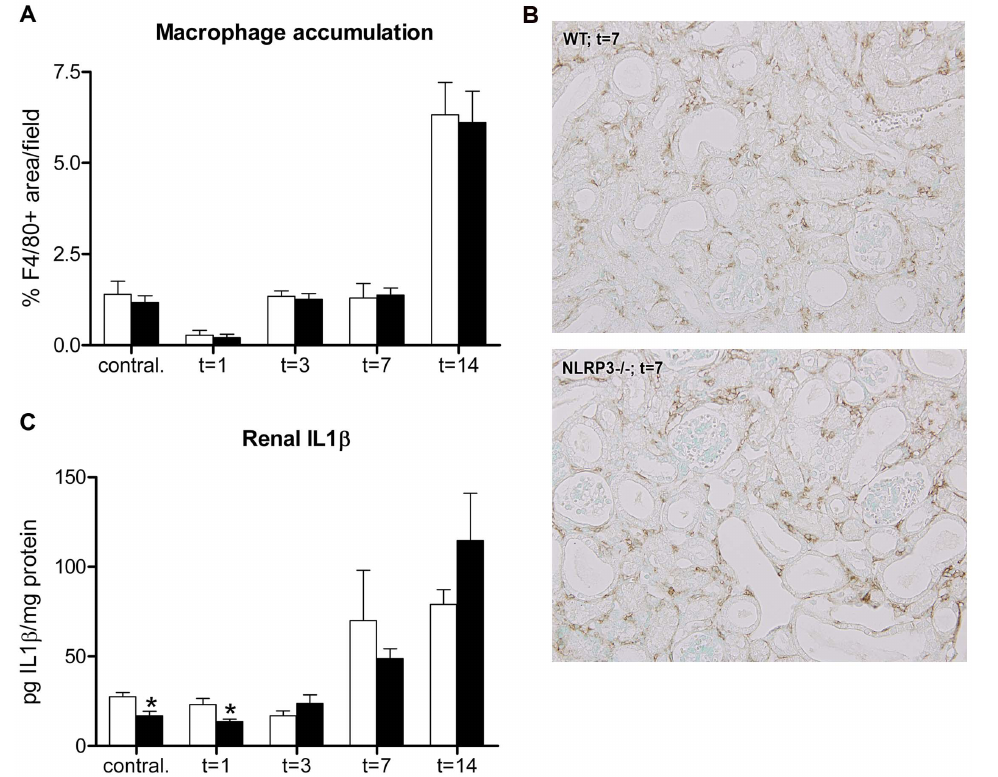
Figure 6. Nlrp3 deficiency reduces early renal IL1- b levels but does not affect macrophage accumulation following UUO. (A) Macrophages progressively accumulated in obstructed kidneys upon UUO and were comparable between wild type (white bars) and Nlrp3 2 / 2 (black bars) mice following UUO. (B) Representative microphotographs of macrophage accumulation in renal tissue sections of mice subjected to 7 days of UUO, magnification x200. (C) Nlrp3 2 / 2 mice displayed less renal IL1- b in their contralateral and obstructed kidneys after 1 day of UUO, whereas levels were comparable to wild type mice at later time points. Data are mean 6 SEM of 7 mice per group and indicated as pg IL1- b per mg protein. Contral. = contralateral kidneys of mice subjected to 14 days of UUO. *:p ,